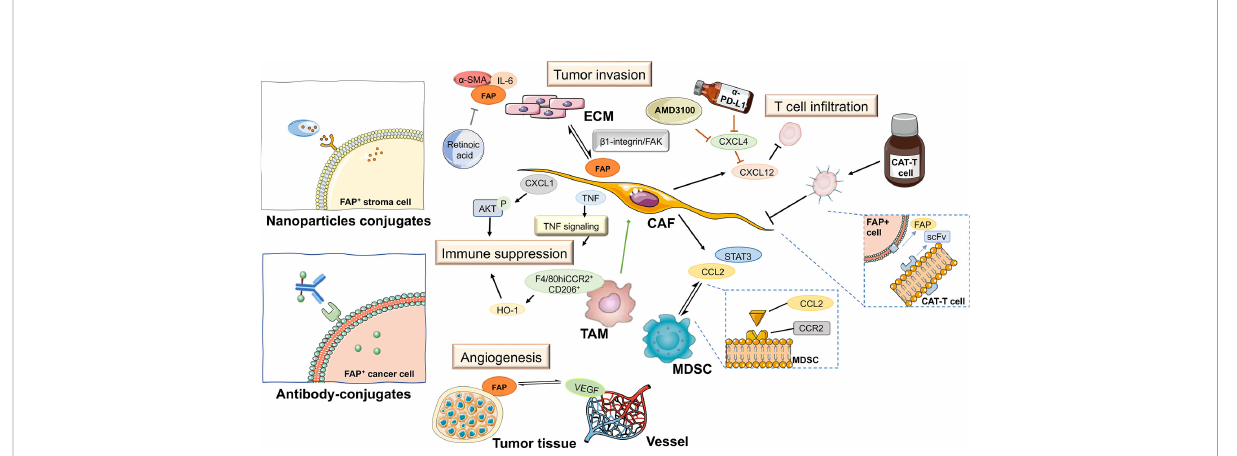
FIGURE 5 FAP-targeted therapies and their expected impact on pancreatic tumor tissue. ECM, extracellular matrix; TAM, tumor-associated macrophage; CAT-T cell, chimeric antigen receptor T cell; MDSC, myeloid-derived suppressor cell; CAF, cancer-associated fi broblast; scFv, fragments of single-chain